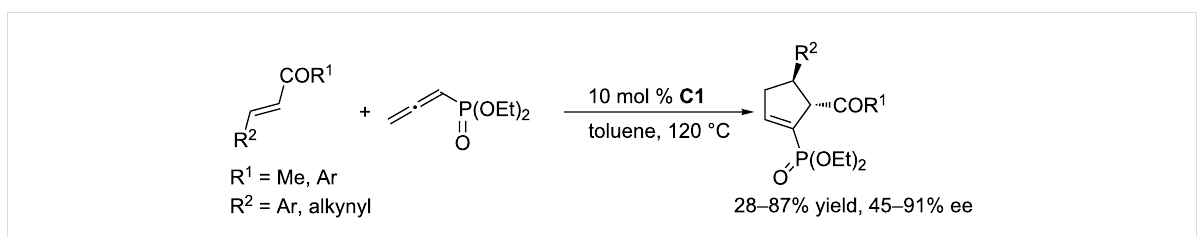
Scheme 11: Asymmetric [3 + 2] annulations of enones with an allenylphosphonate, catalyzed by the ferrocene-modified phosphine C1 .